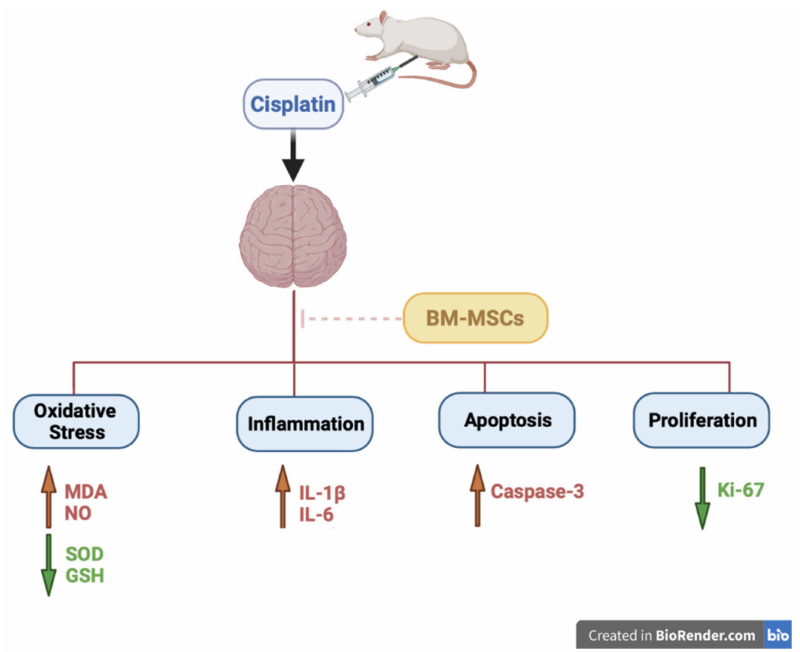
Figure 8. Schematic diagram illustrating the neuroprotective mechanism of BM-MSCs against cisplatin- induced neurotoxicity. BM-MSCs: bone marrow-derived mesenchymal stem cells, MDA: malondialde- hyde, NO: nitric oxide, SOD: superoxide dismutase, GSH: reduced glutathione, IL: